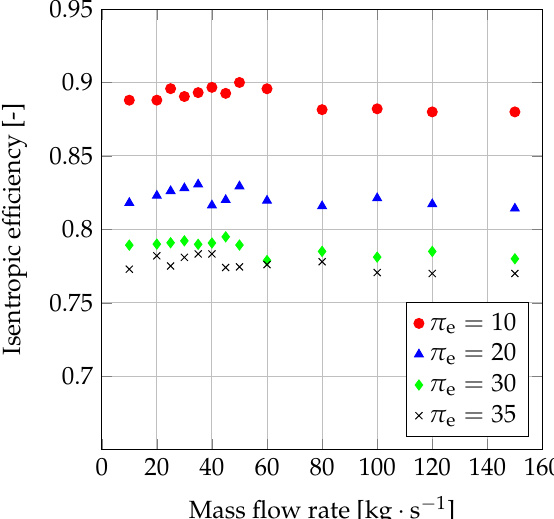
Figure 7. Surrogate turbine model at the optimal rotational speed, relating total-to-total isentropic efficiency to the mass flow rate and pressure ratio across the turbine.